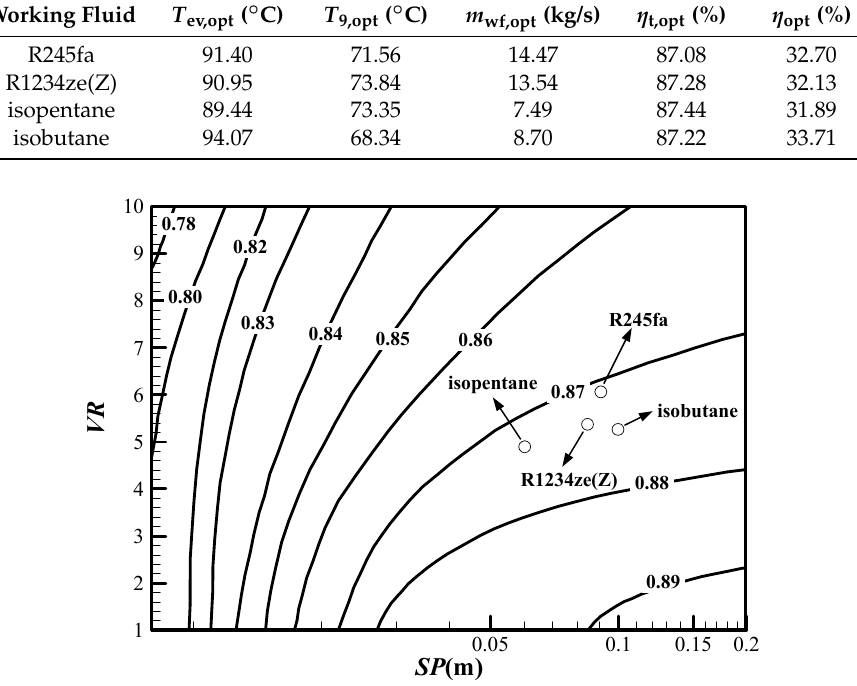
Figure 7. Variation of turbine efficiency with SP and VR at optimal working condition.